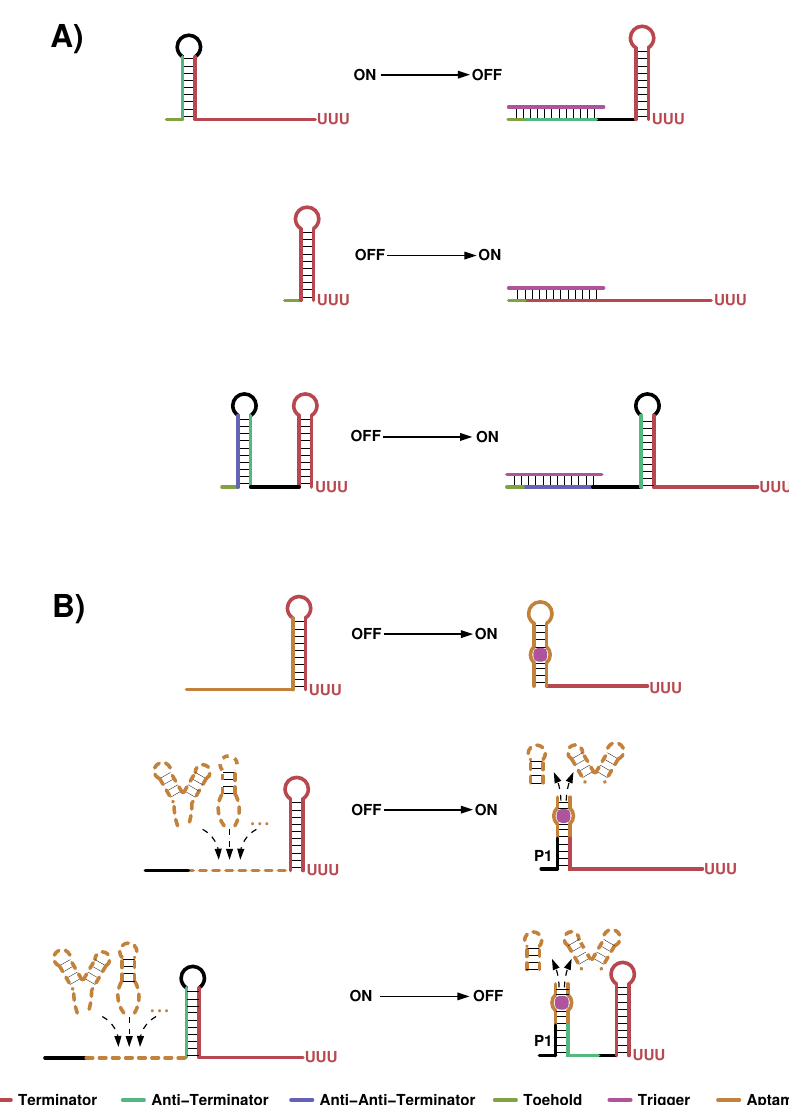
Figure 5. Cartoons to illustrate design ideas of recently published approaches to regulate transcription. ( A ) The sRNA based approach utilized by Chappell et al. [122] is shown. They started from a previously published transcription attenuator (top), where the unbound mRNA transcript folds into an anti-terminator structure. The latter is opened upon sRNA binding, which favors the formation of a transcription terminator. Two possibilities to convert this system into a transcription activator have been investigated by the authors. One is to directly target the 5 (cid:48) part of the terminator stem (middle) and the second adds another layer of structural dependency by attaching an anti-anti-terminator sequence upstream of the initial construct. This causes the formation of an additional stem that sequesters the anti-terminator sequence and thereby ensures the proper terminator fold. ( B ) The aptamer based designs applied in [23,69,123] (top) and [124,125] (middle and bottom) are sketched. The first approach utilizes the stabilizing effect of ligand binding in order to avoid terminator formation, whereas the latter is based on the observation that many aptamers are closed by a typically short P1 stem, which is not essential for ligand recognition. Therefore diverse aptamer sequences can be attached to a generic P1 platform, which is further linked to a downstream terminator. When P1 is stabilized upon ligand binding terminator formation is either prohibited (middle) or facilitated